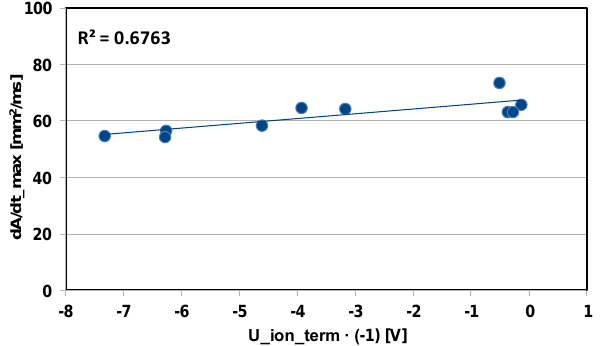
Fig. 10. Correlation of the maximum flame propagation value in the cylinder and the maximum value of thermal ionization